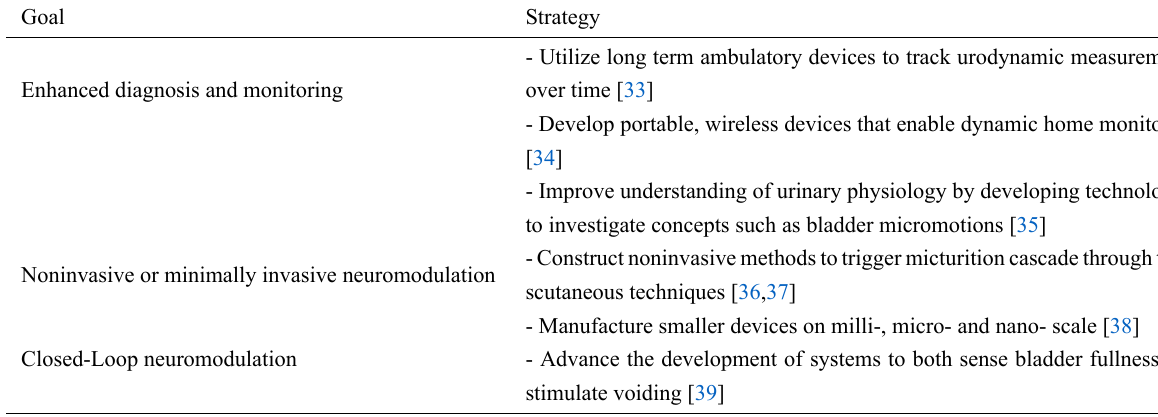
Table 1. New innovations for managing urinary dysfunction following